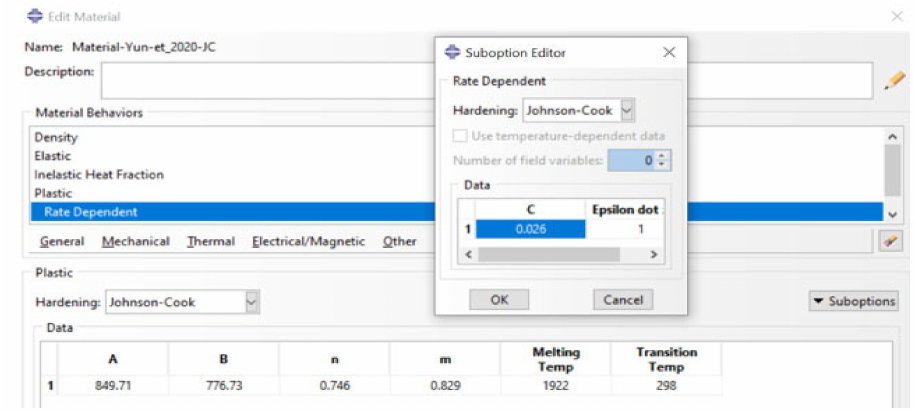
Figure 11. A typical material properties module for the J–C model in-built in